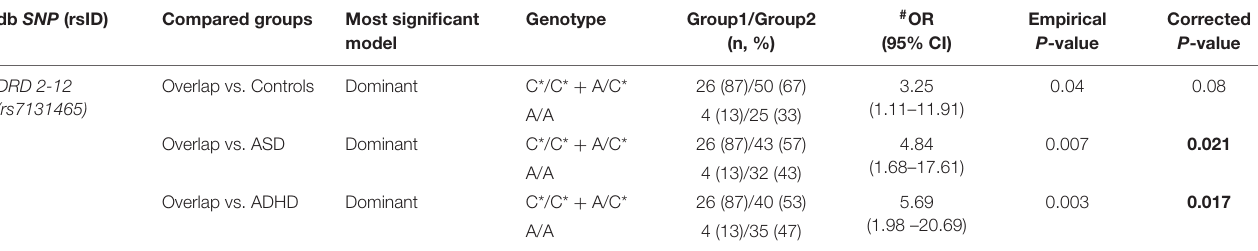
Overlap vs. ASD Overlap vs. ADHD 0 . 001 0 . 003 DRD 1-B (rs4532) ASD vs. CTR 0 . 02 DRD 2-2 (rs11608185)